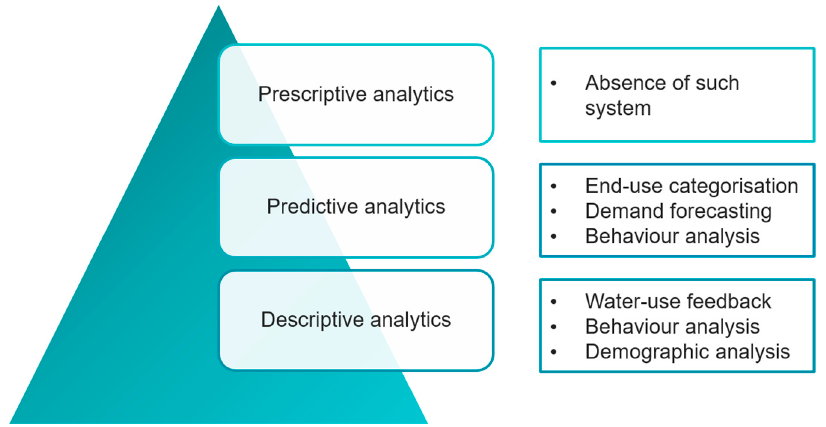
Figure 5. Grouping existing works from a business intelligence perspective.